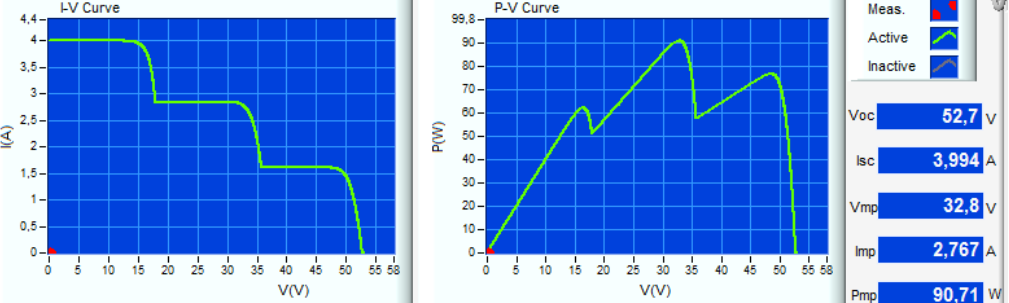
Figure 15. I-V and P-V curve generated by a PV simulator for the first PSC (200 – 400 – 600 W/m 2 ).